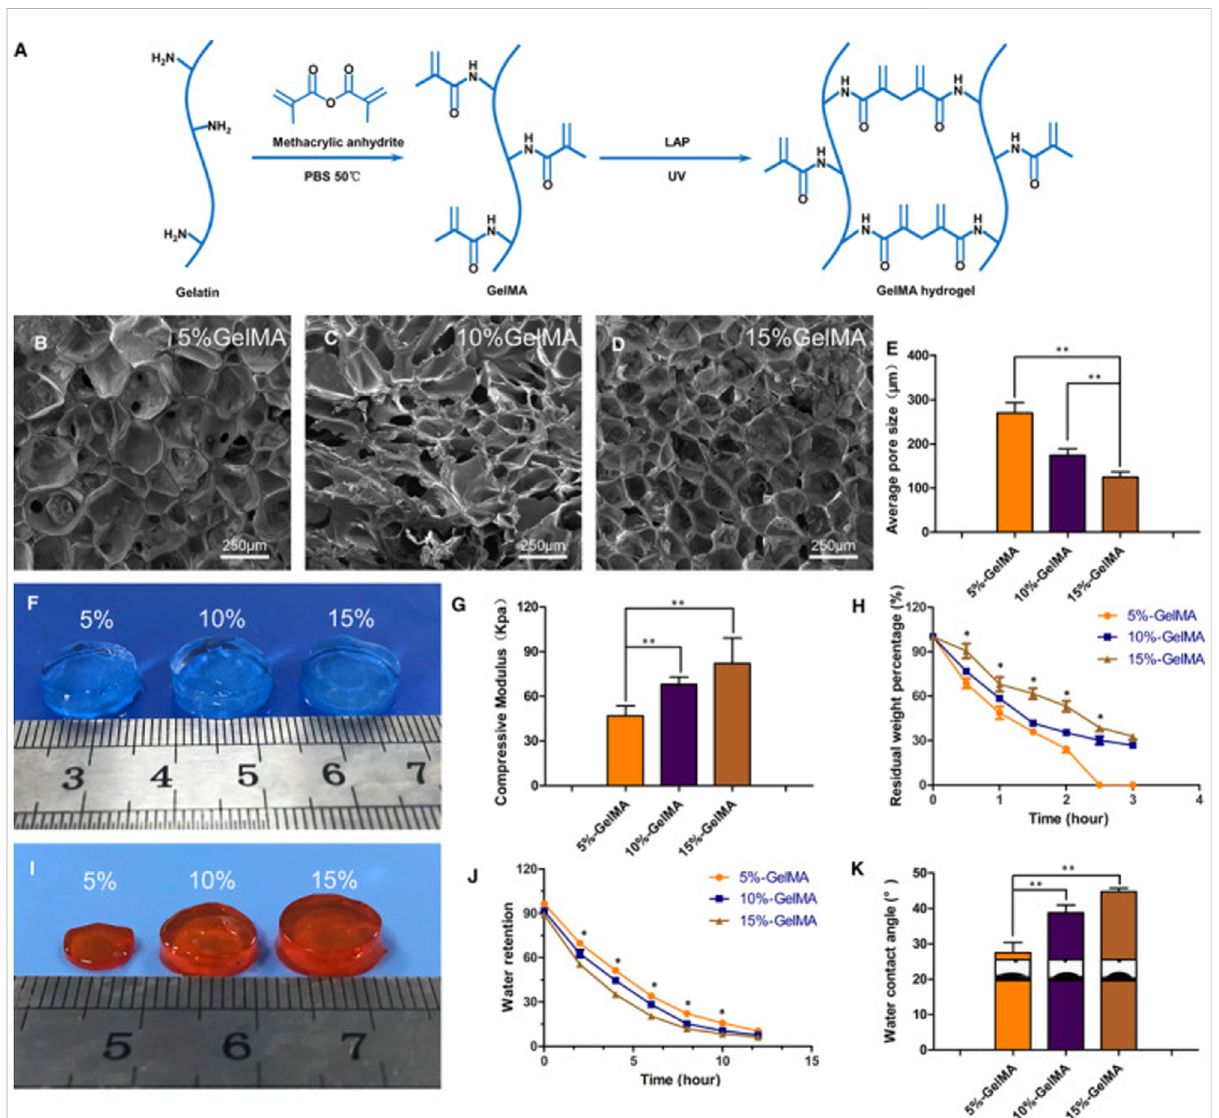
FIGURE 4 Schematic diagram of synthetic molecules of GelMA hydrogels (A) . Scanning electron microscopy was used to observe the microstructure of GelMAhydrogelswithdifferentconcentrations (B – D) .Comparisonoftheporesizeofhydrogelswithdifferentconcentrations (E) .Comparisonofthe appearance of three different concentrations of hydrogels (F) . Comparison of mechanical properties of three different concentrations of hydrogels (G) . Degradation of hydrogels with different concentrations over time in vitro (H) . The appearance of hydrogel after 2 h in vitro degradation (I) . Comparison ofwater bindingcapacity ofhydrogelswithdifferentconcentrations (J) .Comparisonofwater content angle ofhydrogels withdifferent concentrations (K) . (* p < 0.05, ** p < 0.01). Reproduced with permission from (Xu et al.,